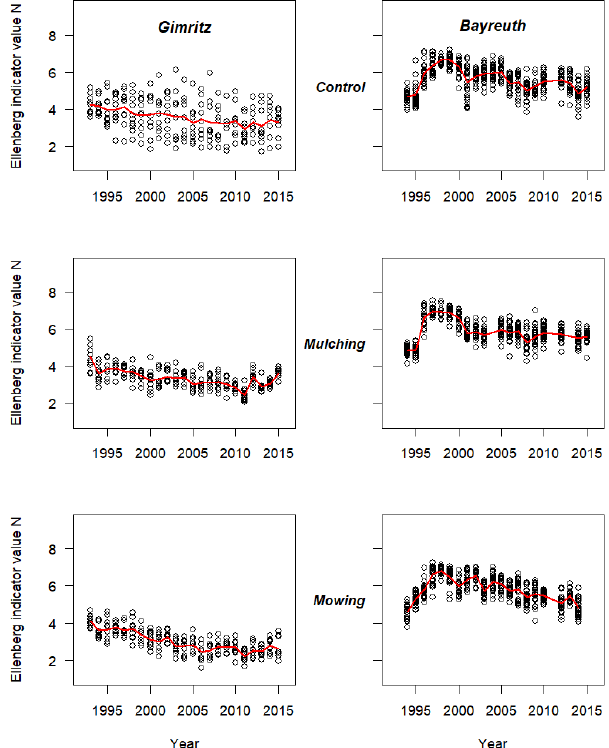
Figure 2. Mean indicator value for soil fertility ( N -value) of sub- plots within each treatment plotted versus years for the study sites Gimritz and Bayreuth (see also Table 3). The red shows the mean across